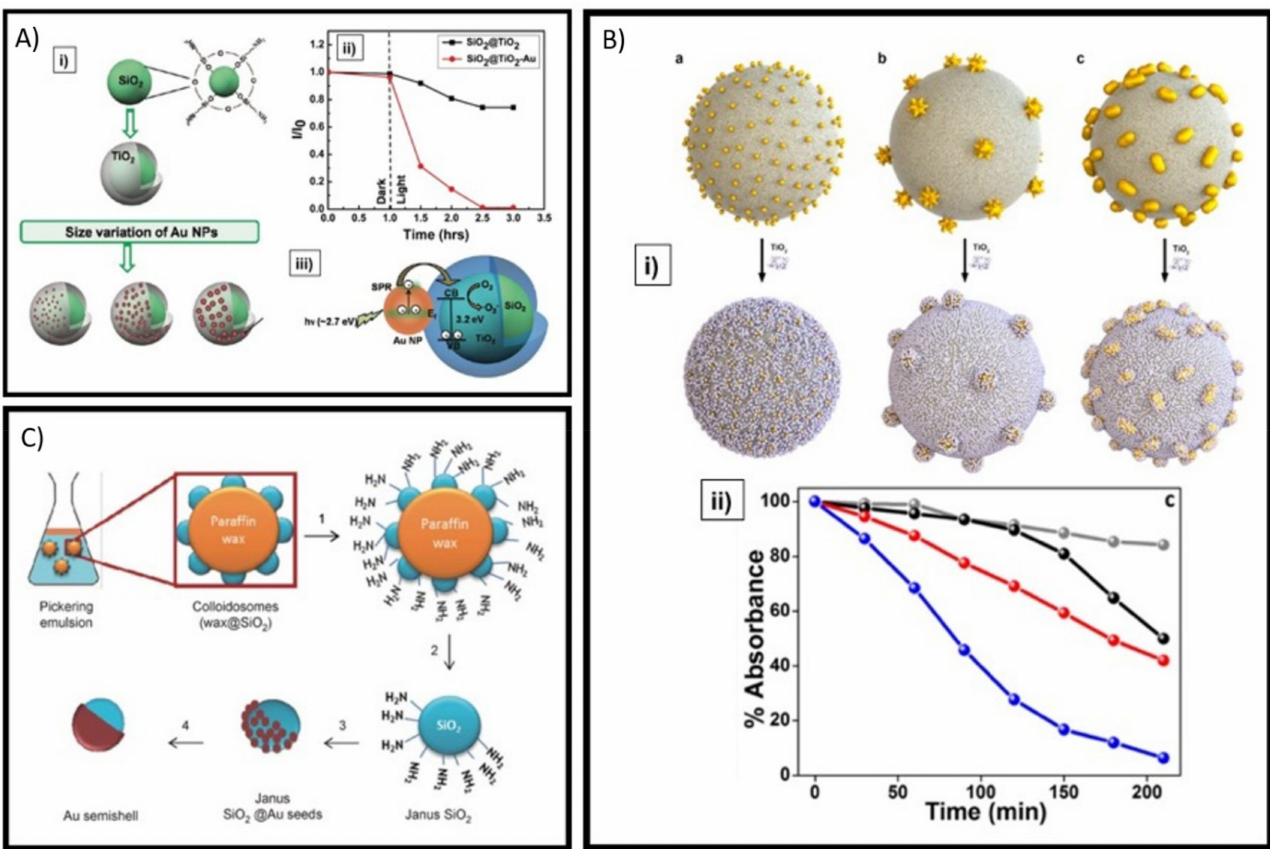
Figure 9. The assembly of hybrid systems incorporating plasmonic NPs-TiO 2 presents good opportunities to develop LSPR-induced visible light active photocatalysts. ( A ) (i) The scheme shows the assembly of Silica-TiO 2 core-shell particles decorated with AuNPs as a LSPR-induced visible light active hybrid system; (ii) presents experimental measurements of the photocatalytic activity of the hybrid system; and (iii) contains a schematic representation of the photocatalysis mechanism. Adapted with permission from Kochuveedu et al. J. Phys. Chem. C. 2012, 116, 2500–2506 Copyright